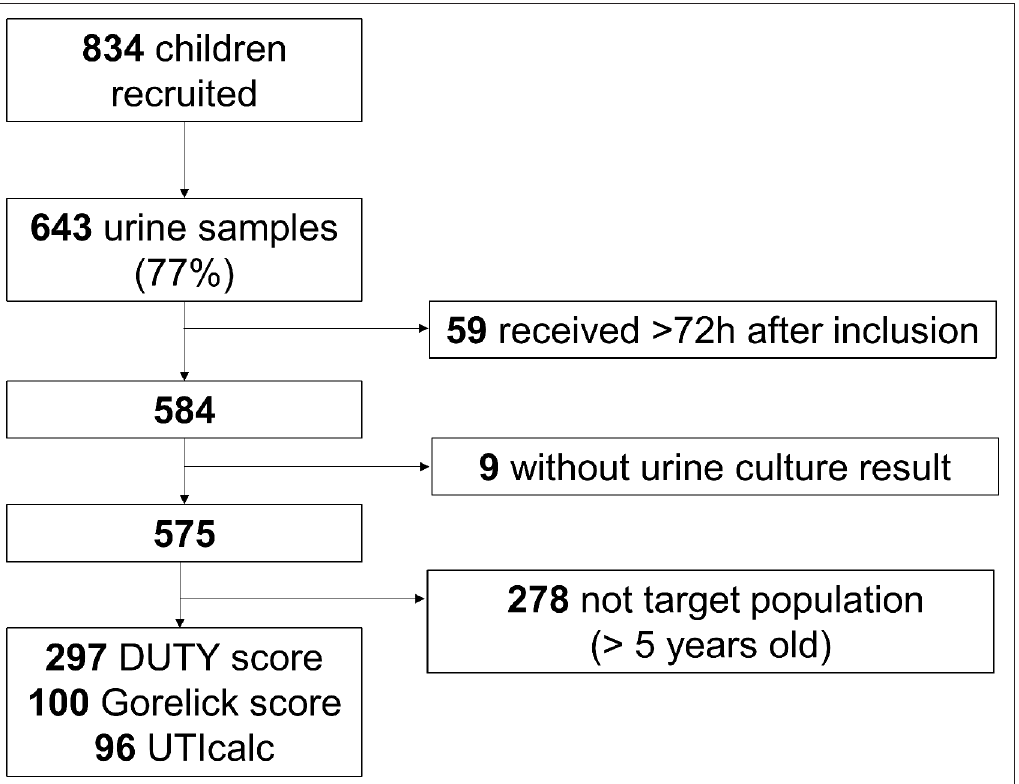
Figure 1 Flowchart of recruited children and urine samples obtained. DUTY = Diagnosis of Urinary Tract Infections in Children. h = hours. UTICalc = UTI